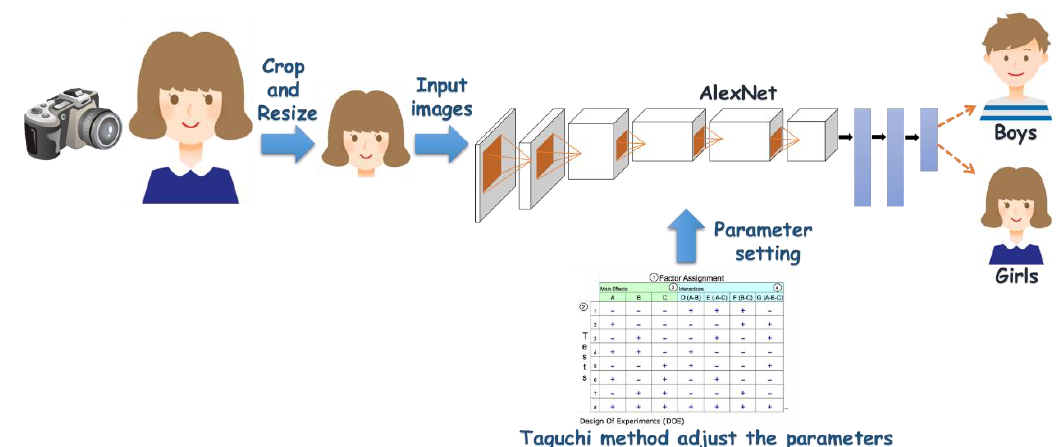
Figure 1. Flowchart of the proposed Taguchi-based AlexNet architecture.